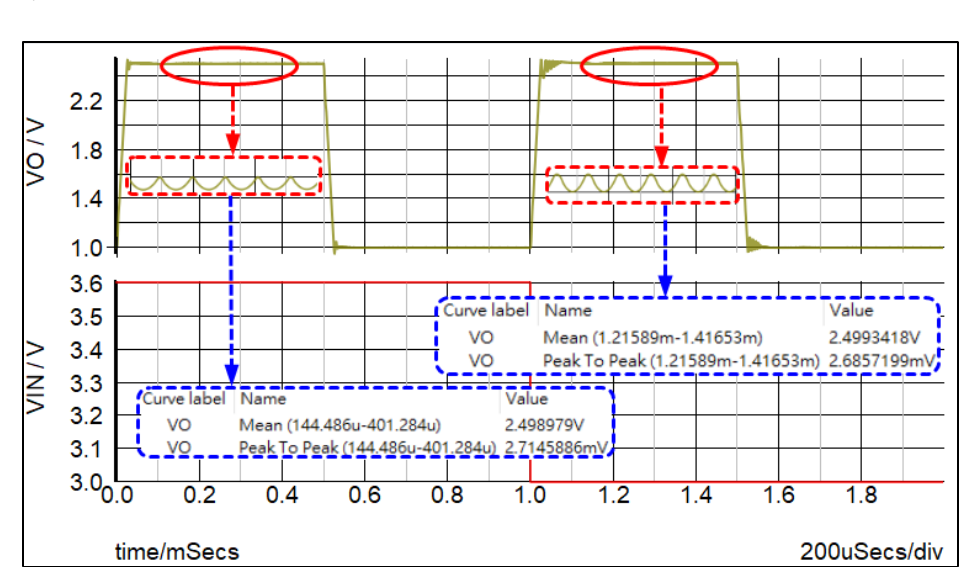
Figure 7. The recovery times for load current transition between 100 – 500 mA. ( a ) step-up. ( b ) step- down.